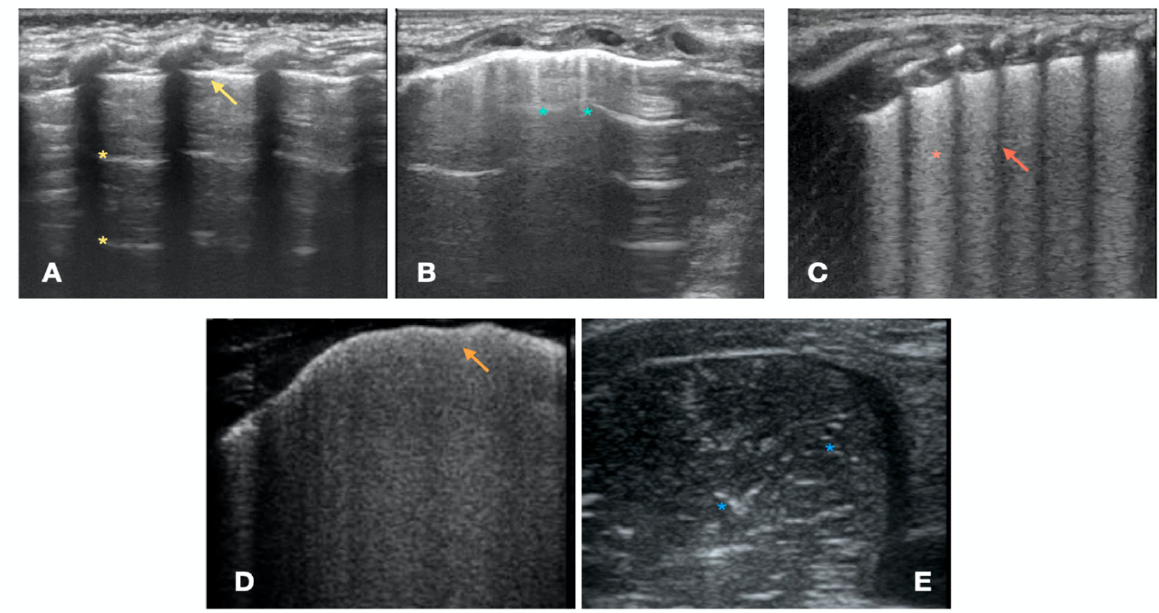
Figure 2. LUS patterns and artifacts. ( A ) A-pattern: normally aerated lung, with A-lines (yellow asterisks) and regular thin pleural line (yellow arrow). ( B ) B1-pattern, moderate loss of lung aeration: three or more B-lines (light-blue asterisks) occupying less than 50% of the scanned area. ( C ) B2- pattern: coalescing B-lines (red asterisk), occupying more than 50% of the scanned area, the acoustic shadow of the ribs is preserved (red arrow). ( D ) “white lung” with coalescing B-lines, erasing the acoustic shadow of the ribs and thickened pleural line (orange arrow). ( E ) C-pattern, complete loss of aeration (aeration score = three) with air bronchogram (blue